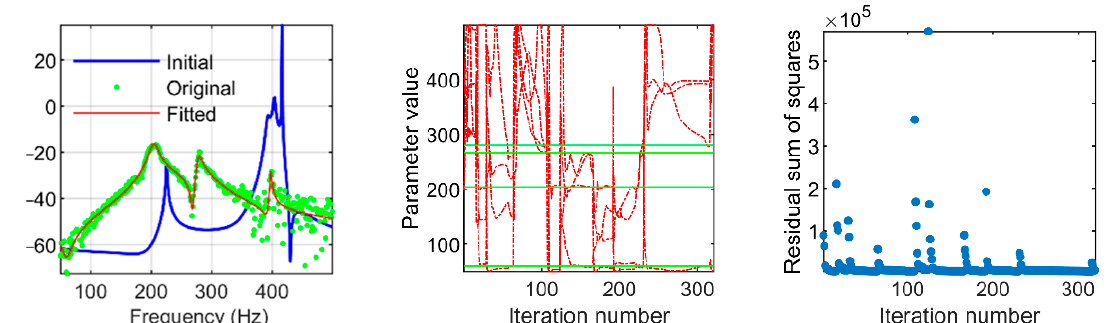
Figure 5. Identification results from synthetic data and Z dB representation: ( left ) visualization of data representation with initial condition and best fit, ( middle ) convergence of found values (red line) to real parameters (green line—resonant and anti-resonant frequencies read manually), ( right ) change in the residual sum of squares in each iteration.